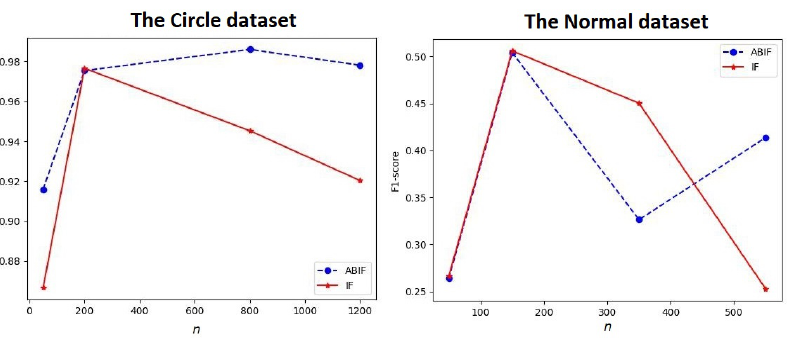
Figure 10. Illustration how the F1-score measures of iForest and ABIForest depend on the number of training data for the Circle dataset (the left panel) and the Normal dataset (the right